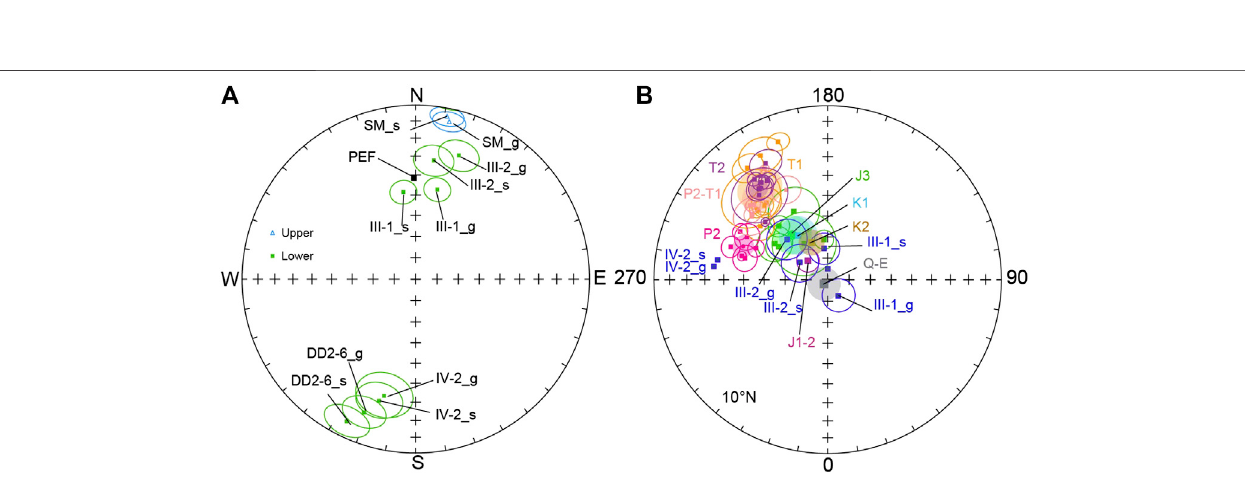
FIGURE 9 | (A) Equal-area projection of paleodirections in Zhaotong area (SM and DD2-6 from Liu et al., 2012) (B) Equal-area projections of the paleomagnetic polesgeneratedin this study(bluesquare) and those ofthe Yangtze Block since Late Permian (Huang et al., 2008; 2018and referencestherein).P 2 , T 1 /T 2 ,J 1 /J 2 /J 3 , K 1 / K 2 , E, Q indicates Late Permian, Early/Late Triassic, Early/Middle/Late Jurassic, Early/Late Cretaceous, Eocene and Quaternary, respectively.